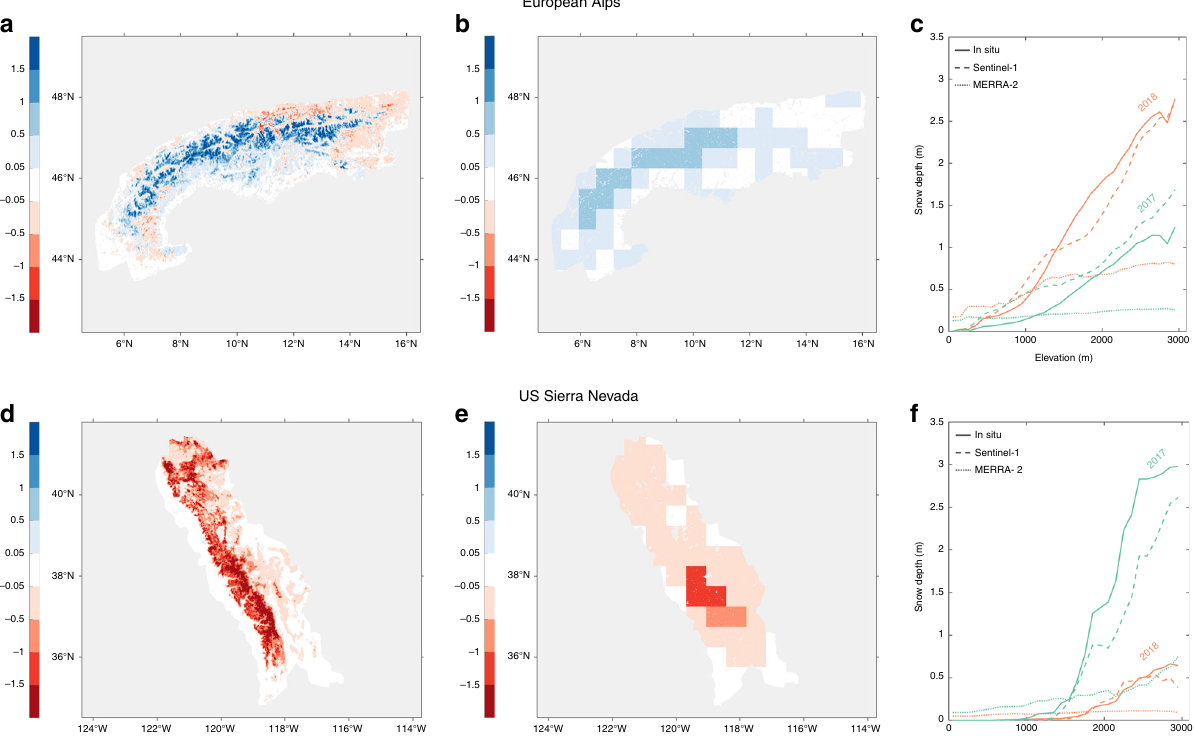
Fig. 7 Inter-annual snow depth differences strati fi ed by elevation. a Snow depth differences (February 2018 minus February 2017; in m) according to 1 km² Sentinel-1 retrievals over the European Alps. b As in a, but for coarse-resolution (0.625° × 0.5°) MERRA-2 reanalysis data. c Snow depth (m) of February 2017 and February 2018 strati fi ed by elevation (m), for in situ measurements, Sentinel-1 retrievals and MERRA-2 reanalysis data (subsampled to the 1 km² grid). d – f As in panels a – c , but for the US Sierra Nevada mountain range. Source data for c,f are provided as a Source Data fi